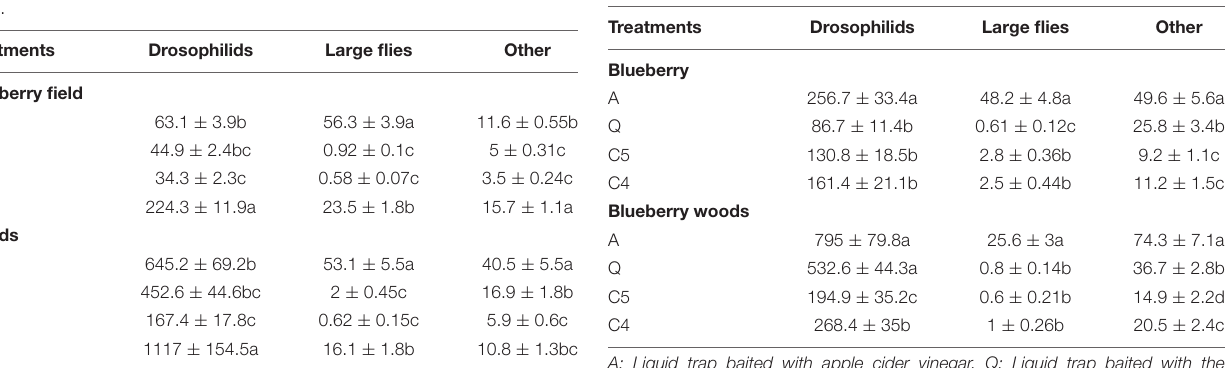
TABLE 3 | Mean ( ± SE) catch (per trap) of non-target: drosophilids, large flies, and other arthropods over the course of trapping (June 13 to October 31; Maryland) in 2018.